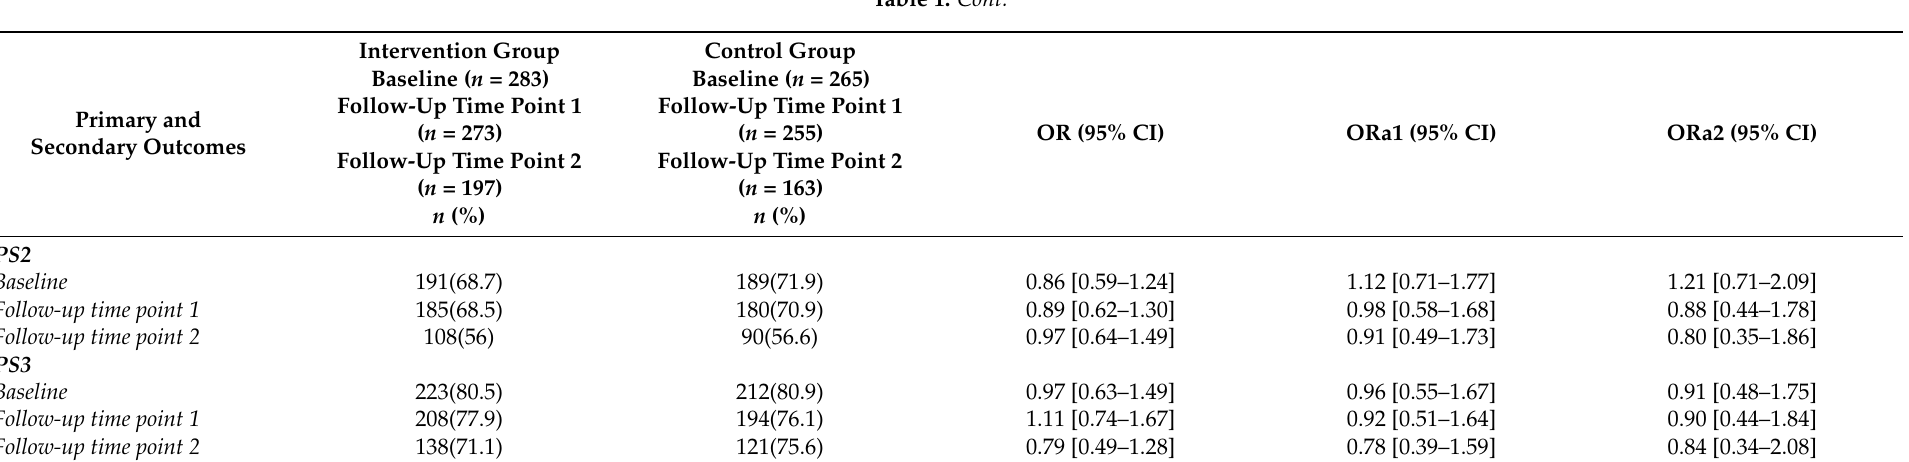
10 of 18 Table 1. Results of the bivariate and multivariate logistic regression analysis at baseline and across follow-up time points 1 and